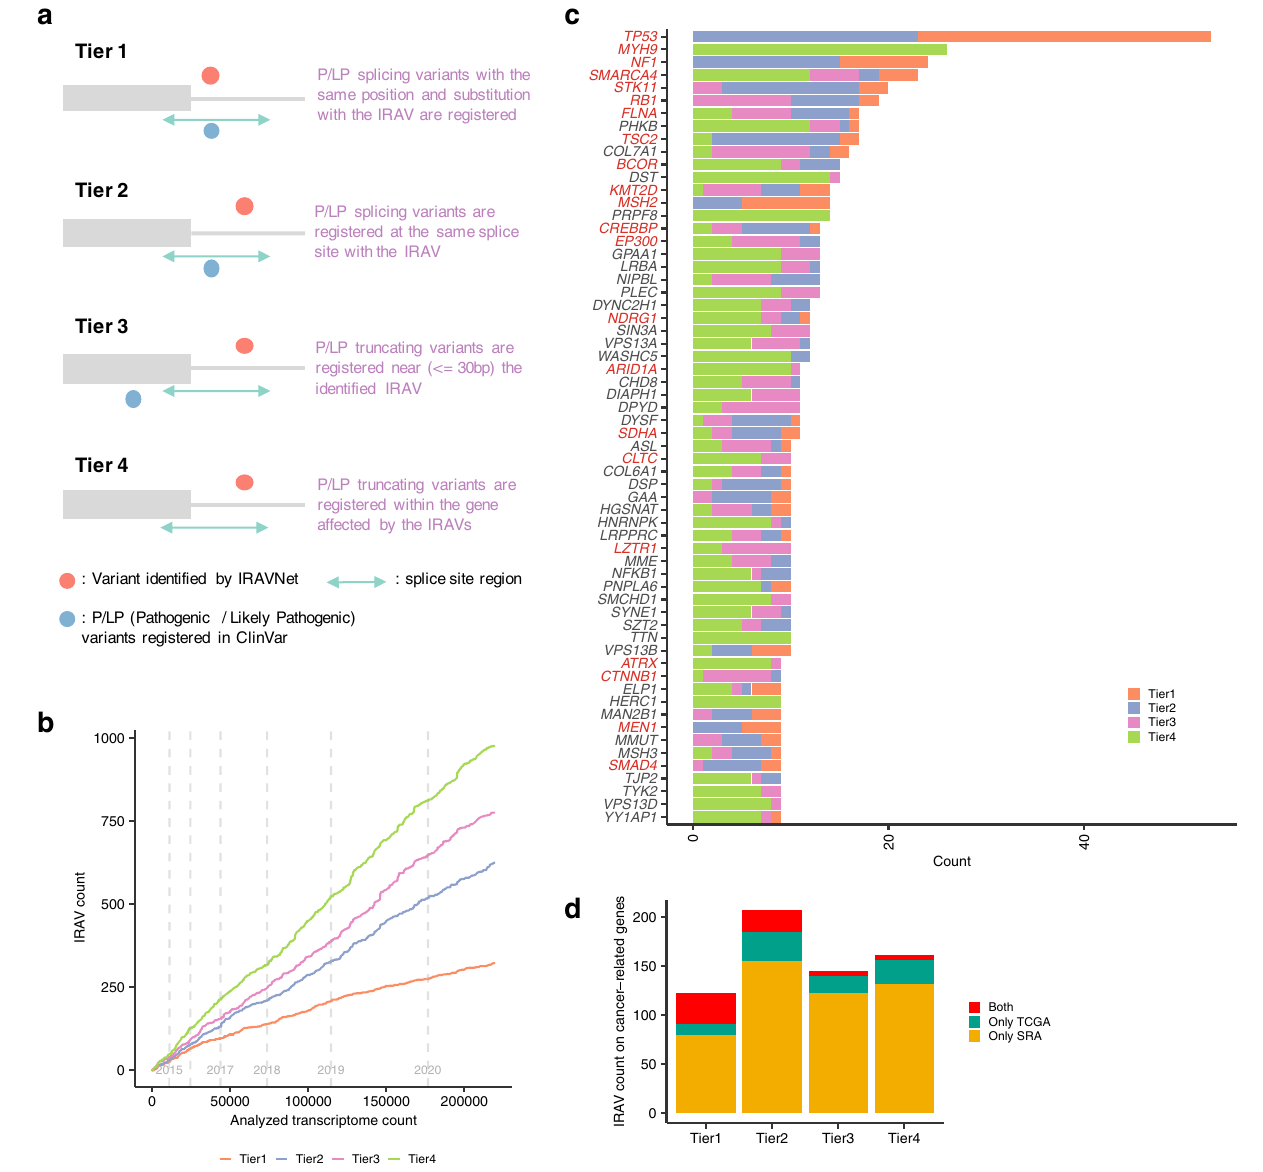
Fig. 4 |ThelandscapeofputativepathogenicIRAVs. a Aconceptualdiagramfor the classi fi cation of disease-related IRAVs in four tiers. The ranks of putative pathogenic IRAVs are determined by comparison with the positional relationships with the registered pathogenic/likely pathogenic (P/LP) variants in ClinVar. b The saturation analysis of putative pathogenic IRAVs via using Sequencing Read Archive. Transcriptome data were sorted by registration date, and the cumulative number of putative pathogenic IRAVs against the number of the analyzed